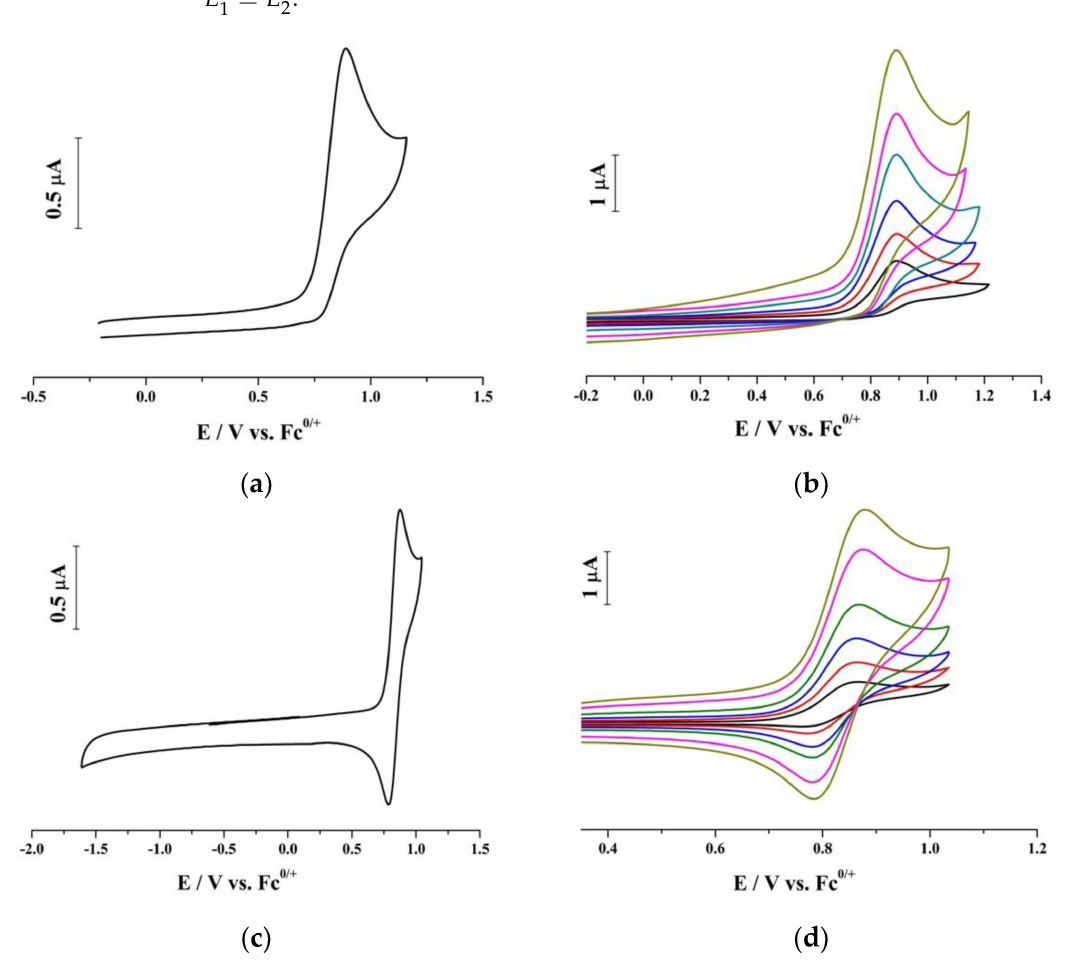
Figure 2. Cyclic voltammograms obtained for 5 mM 1 in ( a , b ) [bmim][PF 6 ], ( c , d ) [bmim][BF 4 ] at a glassy carbon electrode (d = 1 mm). ( a – c ) over a wide potential range with a scan rate of 0.1 V s − 1 and ( b – d ) over the potential region where the oxidation occurs at scan rates of 0.02, 0.05, 0.10, 0.20, 0.40, and 0.60 V s − 1 . T = 21 ± 1 ◦